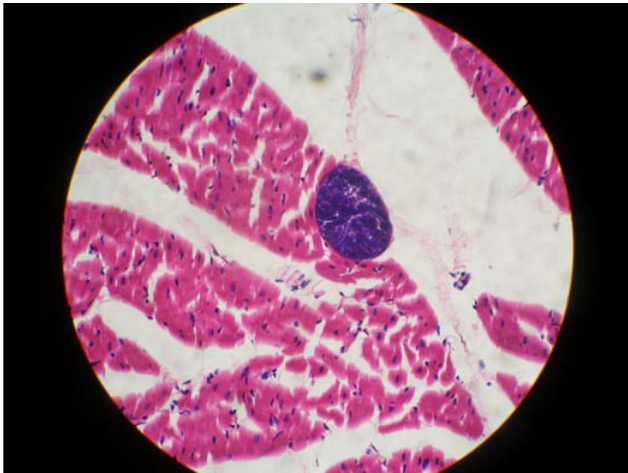
Image 1. Sarcocyst in the heart muscle. H & E,